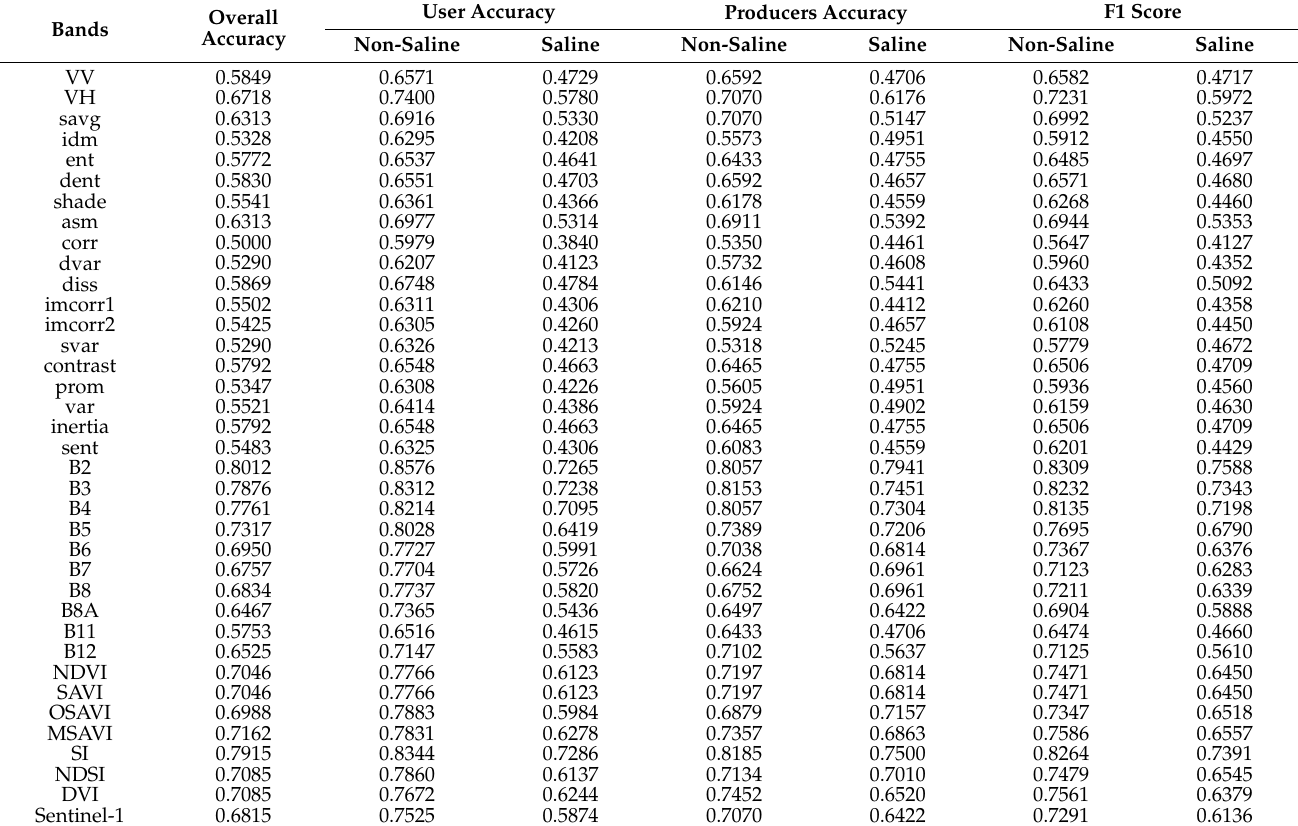
Table A4. Classification accuracies of each variable and datasets for saline cropland